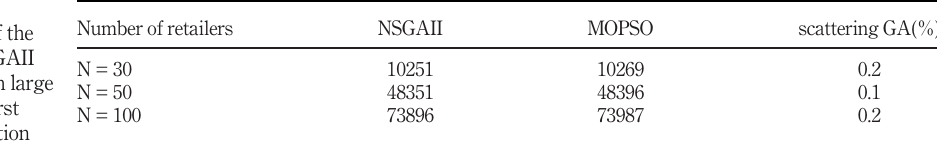
Table 6. Comparison of the answer of NSGAII and MOPSO in large sizes for the second